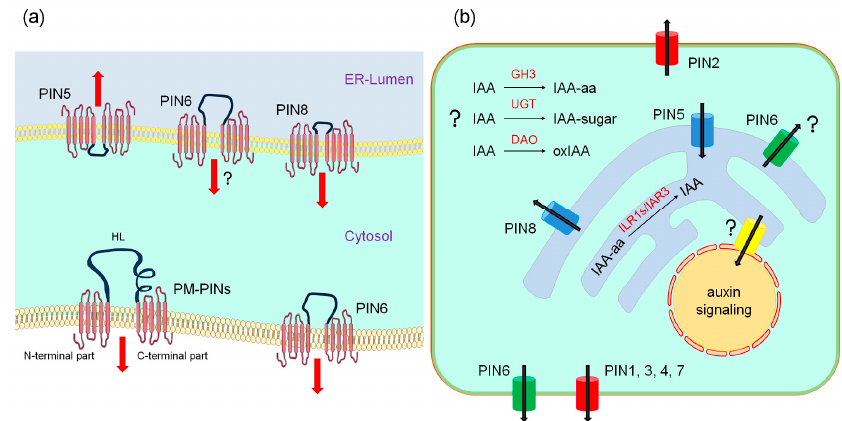
Figure 2. ( a ) The membrane topology, structural properties, and proposed direction of PIN-mediated auxin transport on PM and ER. The composition of the main structural units is illustrated on PM-PINs. ( b ) A scheme of the ER-PIN-mediated auxin transport, including the downstream IAA metabolism. Conversion of IAA to oxIAA or its conjugation to amino acid occurs most probably in the cytoplasm, while IAA de-conjugation was seen in the ER lumen. The subcellular localization of IAA conjugation with sugar moieties is unknown